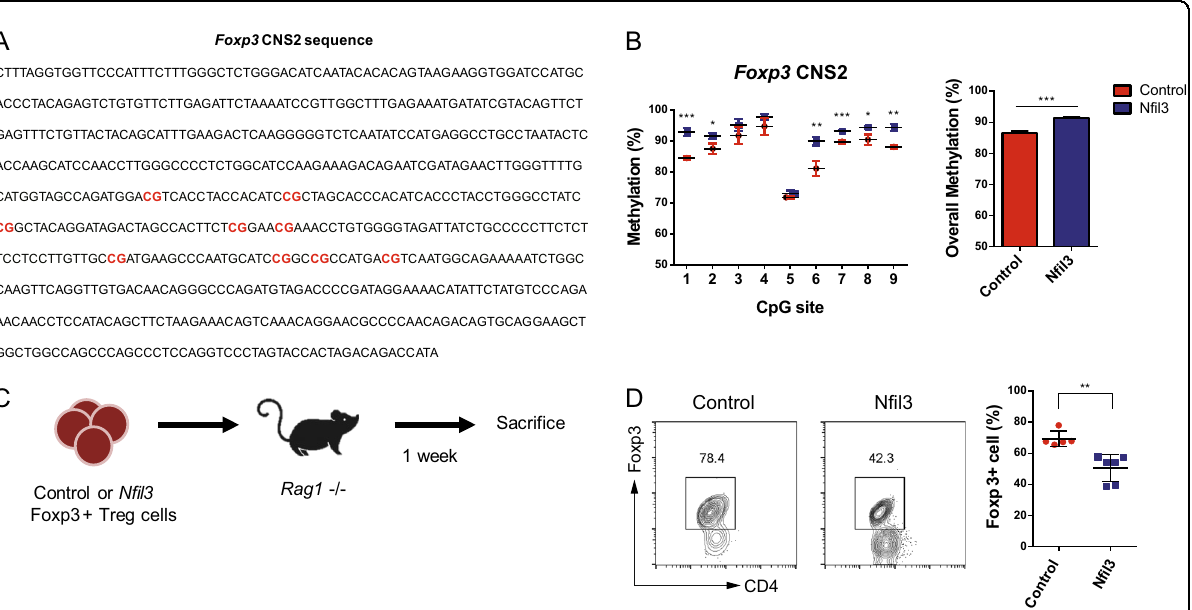
Fig. 6 Overexpression of N fi l3 regulates Treg cell stability. a Sequence of the Foxp3 CNS2 locus. CpG sites are highlighted as red letters. b Methylation at each CpG site (left panel) and overall (right panel) was measured in control or N fi l3 -overexpressing Treg cells by bisul fi te sequencing. Data are pooled from three independent experiments. In vivo Treg cell stability assay. ( c ) Schematic illustration of the in vivo stability assay. Naive CD4 T cells were isolated from Foxp3 eGFP mice and transduced with empty or N fi l3 -hCD4-overexpressing vectors under Treg-polarizing conditions. Only transfected Treg cells (eGFP + hCD4 + ) were sorted. Cells (2.0 × 10 5 ) were injected into Rag1 − / − mice, and after 1 week, splenocytes were isolated and analyzed. ( d ) Percentages of CD4 + Foxp3 + cells were measured in splenocytes ( c ) by fl ow cytometry. Representative FACS plot (left panel) and analysis of the statistical signi fi cance of differences between the two groups (right panel). Data are pooled from fi ve to six individual experiments. Error bars represent the SD. The signi fi cance of the differences between groups was determined by Student ’ s t test. * P < 0.05, ** P < 0.01, *** P < 0.001, and **** P < 0.0001, n.s. not signi fi